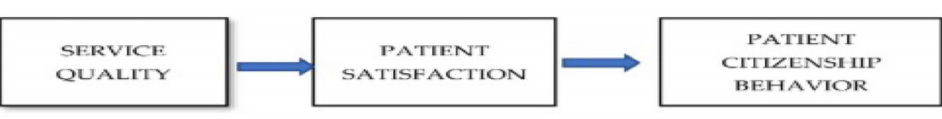
Figure 2. Mediating Effect of Patient Satisfaction.